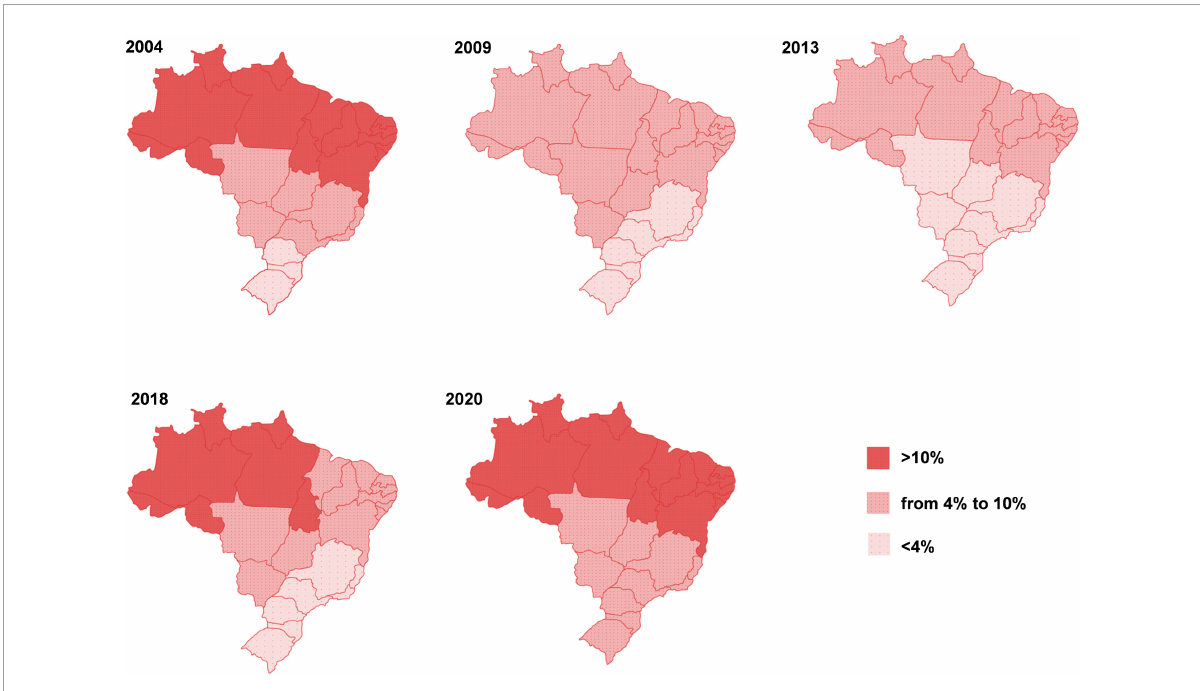
FIGURE1 Evolution of hunger in Brazil. The figure shows the percentage of the population affected by severe food insecurity from 2004 to 2020, seen in different macro-regions of the country. Figure reproduced (with permission) from the Report of the National Survey of Food Insecurity in the Context the COVID-19 Pandemic in Brazil published by the Brazilian Research Network of Food and Nutrition Sovereignty and Security (applied herein with permission from Rede PENSSAN,